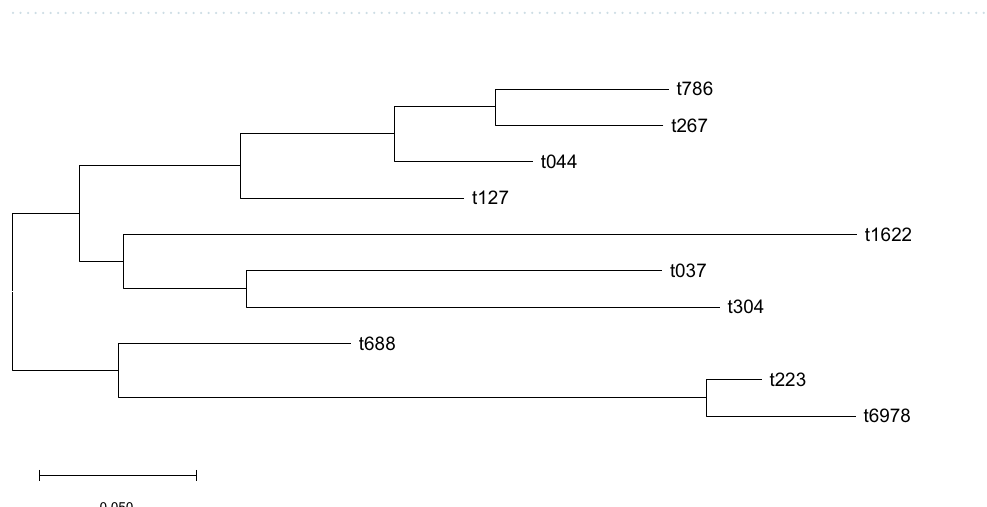
Figure 1. Moxifloxacin resistance among the isolates in hospital acquired (HA) and community acquired (CA) infections. Moxifloxacin resistance was seen among 78% of HA isolates, 64% of CA isolates and 50% of isolates of unknown infection type.